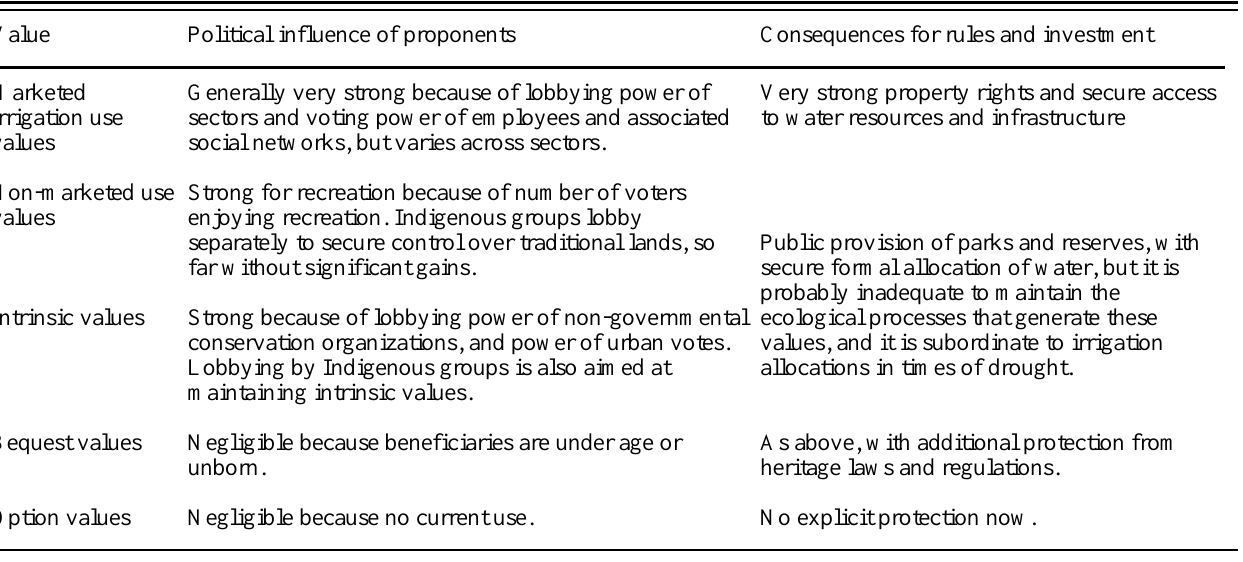
Table 1. Ability of proponents of particular values to influence changes in rules and investments to favor their